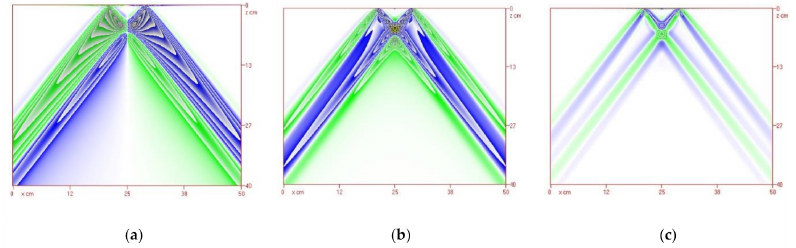
Figure 1. Periodic internal waves beams and a family of ligaments (envelopes of beams and thin flows on the emitting surface), generated by vertical oscillations of a horizontal disk D = 8 cm in diameter with a period of T o = 6.3 s and a velocity amplitude of U o = 0.25 cm/s in a liquid with a buoyancy period of T b = 4.2 s: ( a – c )—fields of the vertical component of velocity ν z , the first ∂ν z second derivatives ∂ 2 ν z . ∂ r 2